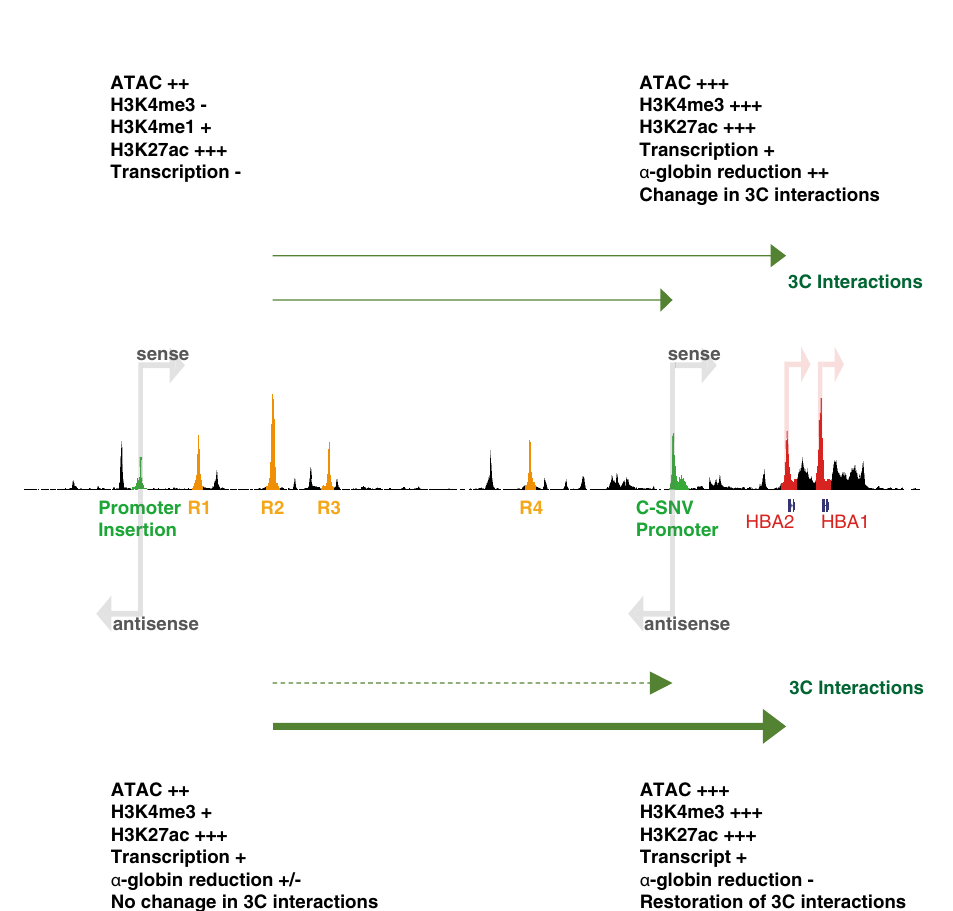
Fig. 5 Changing the orientation of the promoter alleviates repression and increases α -globin enhancer-promoter contacts. A The native promoter was inverted using heterotypical loxP sites located 4011 bp upstream and 2975 bp downstream of the XCPE1 TSS (fragment chr16:205,734-212,720, hg19). B ATAC-seq: the enhancer elements (R1 to R4) are highlighted in orange, the site of the T to C mutation is highlighted in green (SNV), the inverted region is highlighted in light blue, gene annotation by Refseq is in blue. Read-densities represent an average of: 3 C-SNV iPSC clones (labelled C-SNV), 3 clones of edited C-SNV cell line LA01 where the heterotypical loxP sites are inserted but the C-SNV promoter segment is not inverted (labelled nonINV), 3 clones of edited patient line LA01 where the C-SNV promoter segment is inverted (labelled INV). Reads for C-SNV and nonINV were mapped to the normal genome, reads for INV were mapped to a custom genome where a 7 kb segment containing the C-SNV promoter is inverted. Coordinates (hg19) chr16:108,000- 238,000. C ChIP-seq, highlighted regions are as in a). Read-densities represent an average of 2 or 3 independent differentiation experiments, 3 C-SNV iPSC clones (C-SNV in red), 2 clones of INV cells (INV in purple). Reads for C-SNV were mapped to the normal genome, reads for INV were mapped to a custom genome. Coordinates (hg19) chr16:108,000-238,000. D Strand-speci fi c RNA-seq of polyadenylated selected (pA + ) and non-polyadenylated (pA-) RNA, read density (in RPKM) represents an average of 2 or 3 independent differentiation experiments: 3 C-SNV iPSC clones (C-SNV) or 2 clones of INV cells (INV). The inverted segment is highlighted in blue, the location of the LoxP sites is marked by orange triangles, the region of the T to C mutation is highlighted in green (SNV), gene annotation by Refseq is in blue with pseudogenes in pink. Reads for C-SNV were mapped to the normal genome, reads for INV were mapped to a custom genome. Coordinates (hg19) chr16:202,000-217,000. E qPCR quanti fi cation of HBA1/HBA2 in reference to RPS18 in mRNA obtained from independent differentiation experiments: 3 independent wild type iPSC lines differentiated twice (WT), 3 C-SNV iPSC clones (C-SNV) differentiated twice (one replicate removed as an outlier), 3 clones of nonINV cells (nonINV), 3 clones of INV cells (INV). WT ( n = 6) in blue, C-SNV ( n = 5) in red, nonINV ( n = 3) in orange, INV ( n = 3) in purple. Violin plots display median (dashed black line) quartile lines (coloured dotted line) and individual data points (black dots). P-values are obtained using unpaired, two-tailed student t -test. F Top panel shows overlaid, normalised Capture-C data for either the promoters of the α -globin genes (left graph) or enhancer R2 (right graph) in erythroid cells derived from 3 independent differentiation experiments: 3 C-SNV clones (C-SNV in red) or 3 clones of INV cells (INV in purple). The mean, plus and minus one standard deviation (S.D.), of sliding 5 kb windows are visualised as a dark coloured line and a lighter coloured shadow, respectively. Differential tracks (in dashed rectangle) show a subtraction (INV minus C-SNV) of the mean value of meaningful interactions per restriction fragment. Reads were mapped to the wild type genome. Coordinates (hg19) chr16:69,200-327,999.